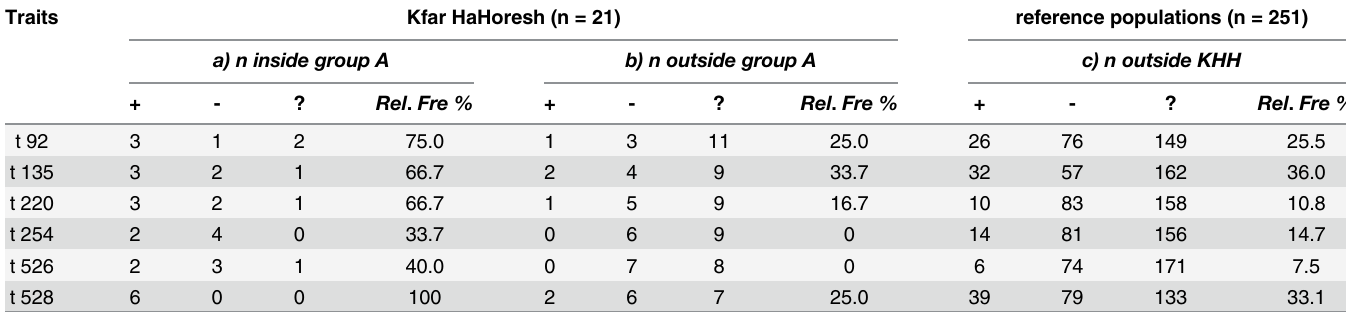
Table 6. Frequencies of group defining traits for Group A.